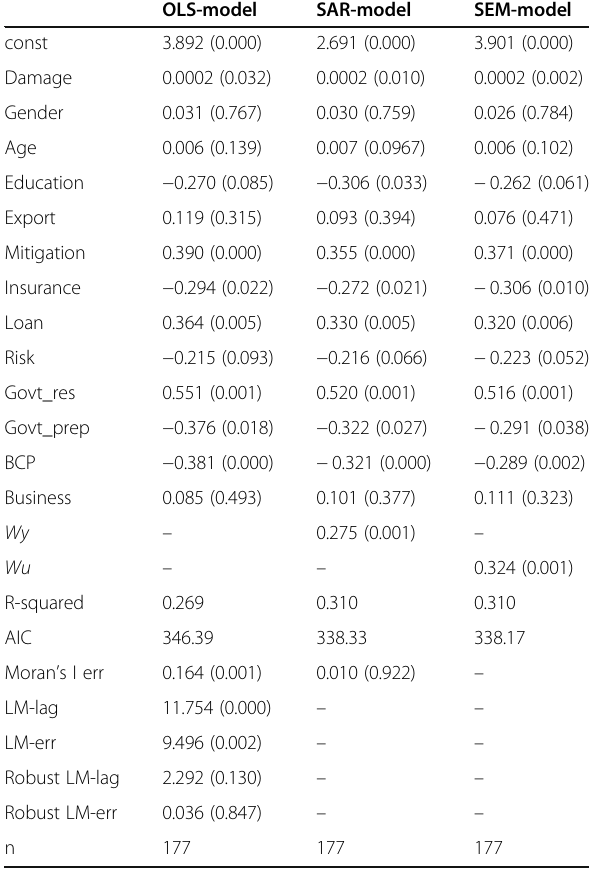
Table 3 Models. Dependent variable: lnDRTP